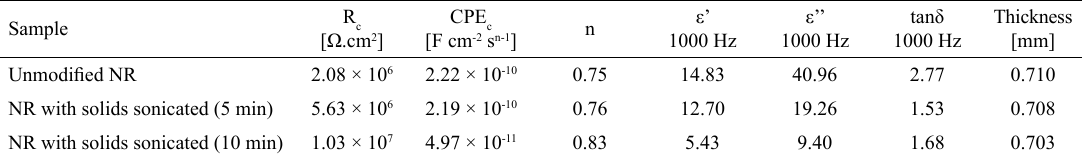
), constant phase elements (CPE) and dielectric parameters (at 1000 Hz and room temperature) for each Table 3. Coating resistance (R c sample analysed with a capacitor cell and after adjusting the parameters using the electrical equivalent circuit (EEC) shown in Figure 7b.